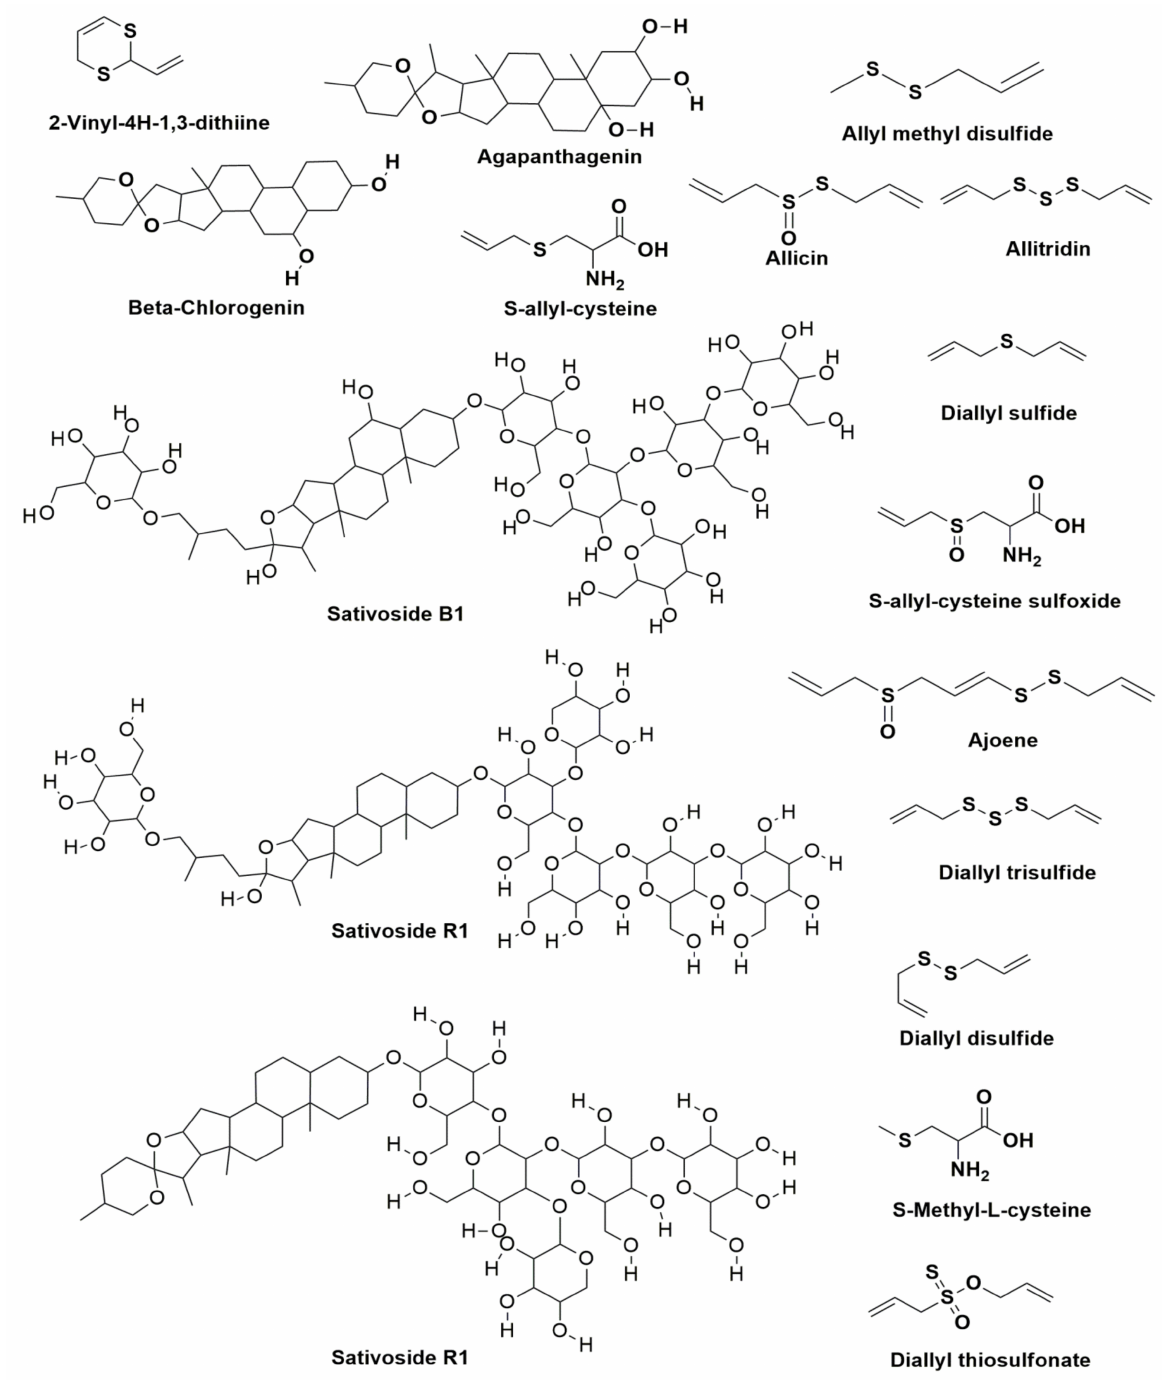
Figure 9. The bioactive compounds from Allium sativum (garlic) and their chemical